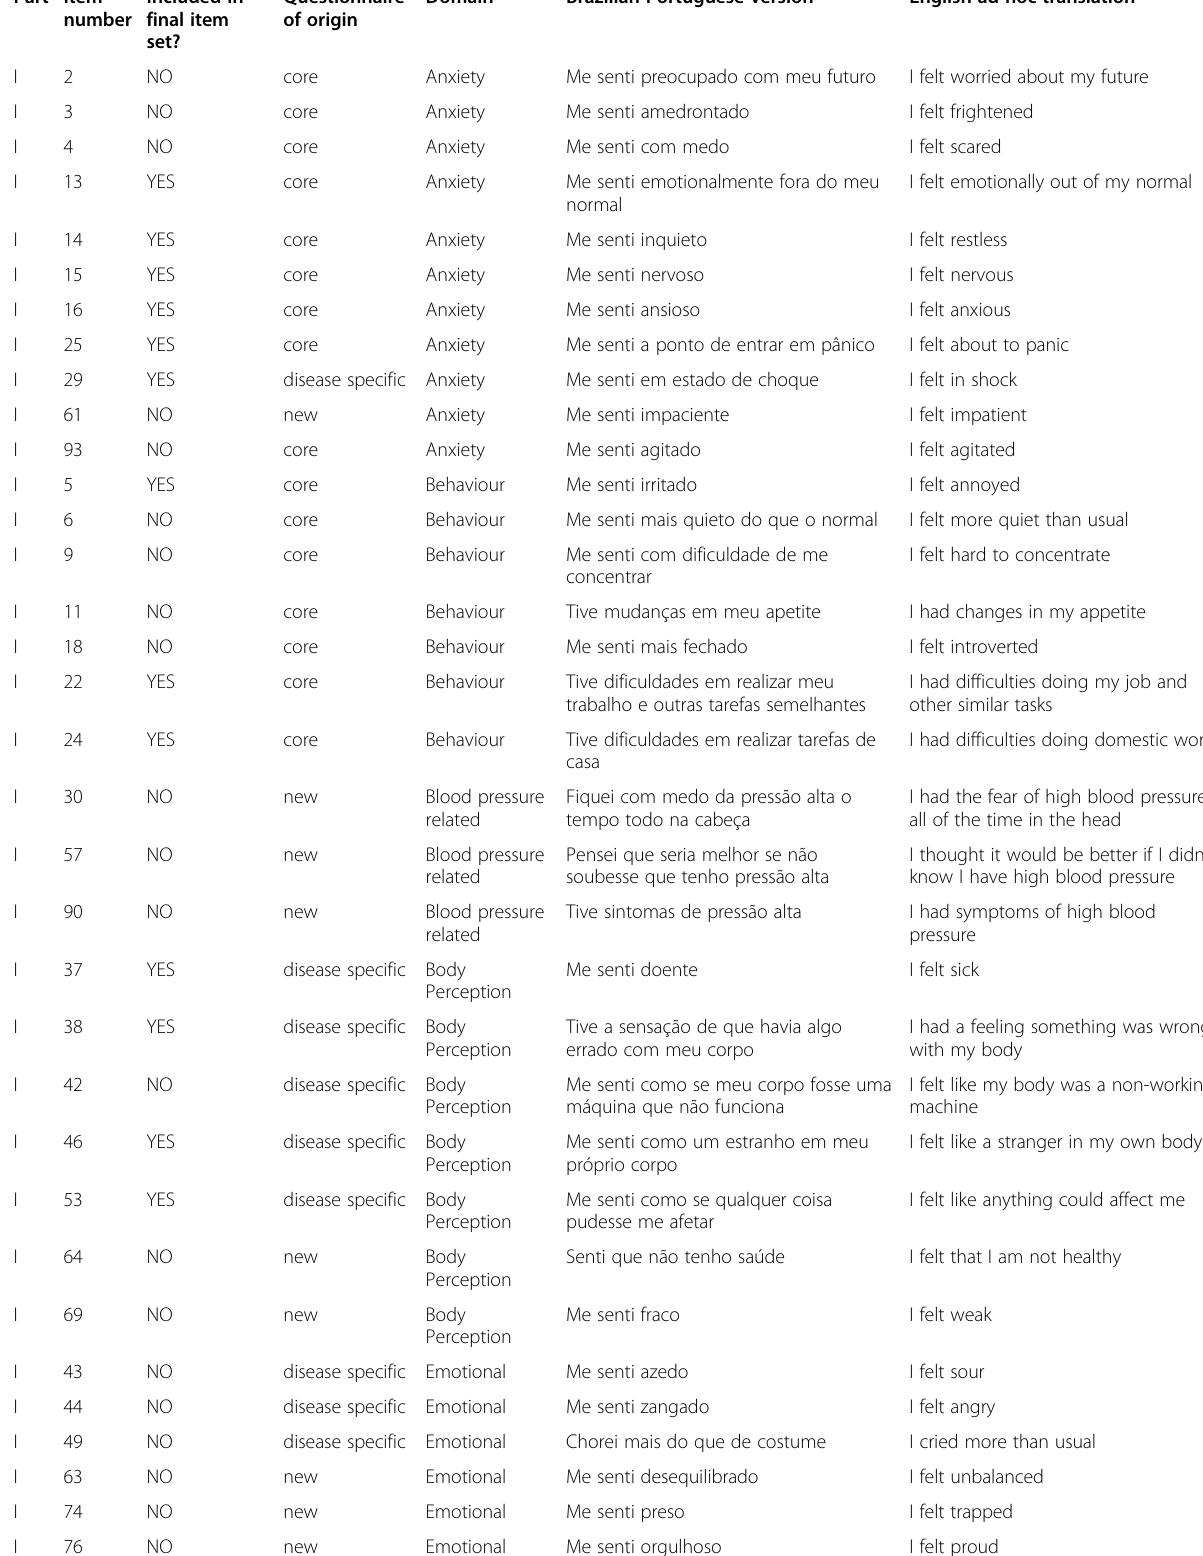
Table 1 Item pool Part Item Included in number final